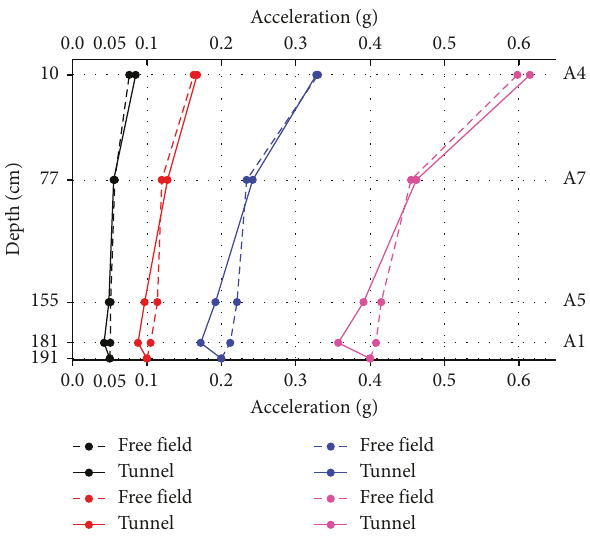
Figure 9: Profiles of maximum acceleration with Chichi excitation.